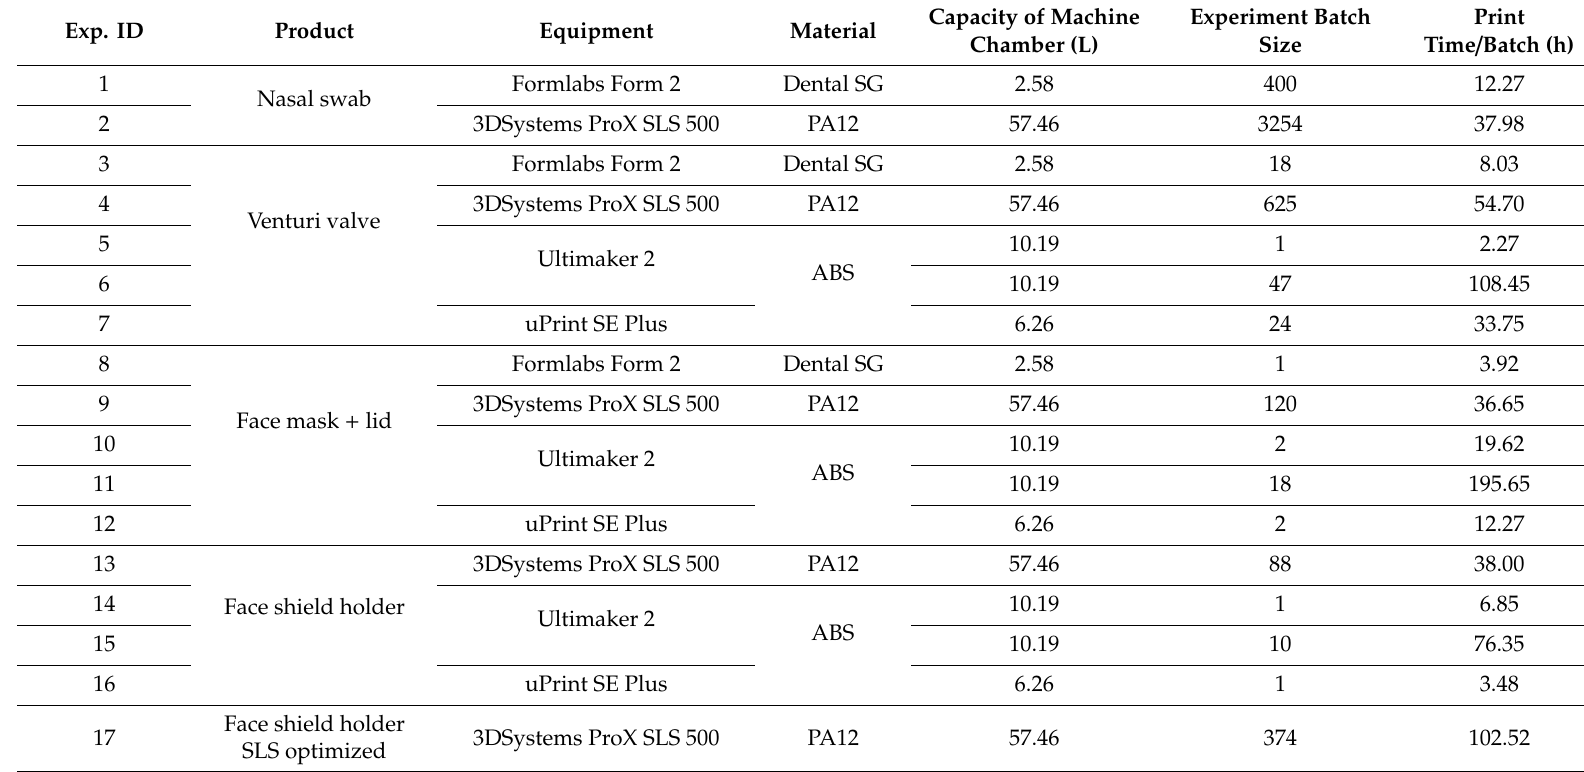
Table 3. Experiment settings and model